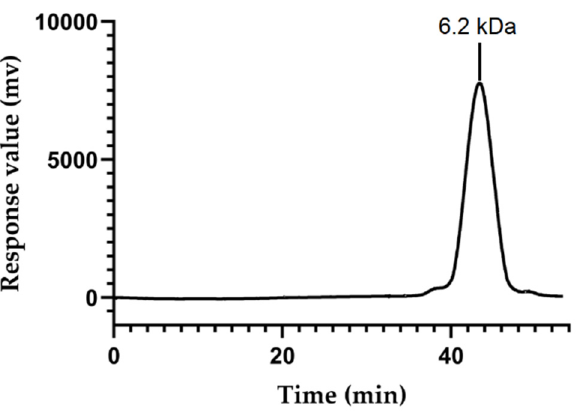
Figure 2. HPGPC profile of OFP.